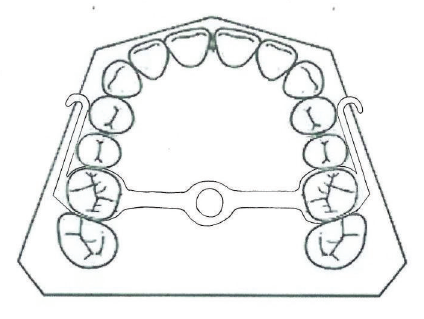
Figure 5: Face mask with skeletal